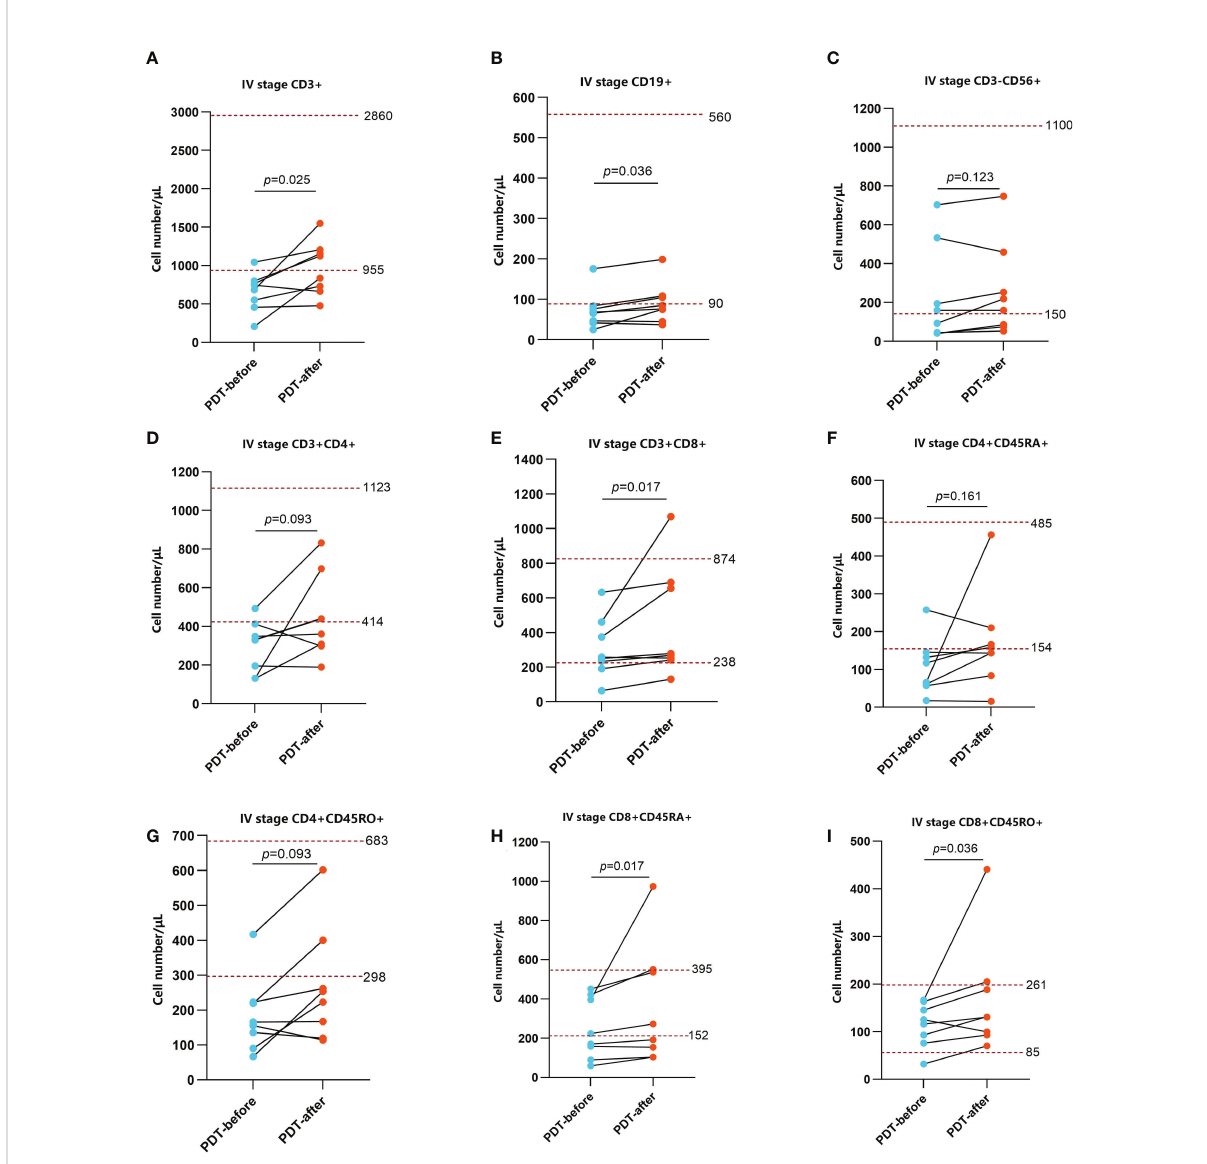
FIGURE 5 Changes in peripheral blood immune function in stage IV patients before and after PDT 48h (n=8). The number of CD3 + T cells, CD19 + B cells, CD3 + CD8 + T cells, CD8 + CD45RA + T cells, CD8 + CD45RO + T cells were relatively lower before PDT and increased signi fi cantly 48h after PDT (A, B, E, H, I) . The changes of CD3 - CD56 + NK cells, CD3 + CD4 + T cells, CD4 + CD45RA + T cells CD4 + CD45RO + T cells were not obvious (C, D, F, G)